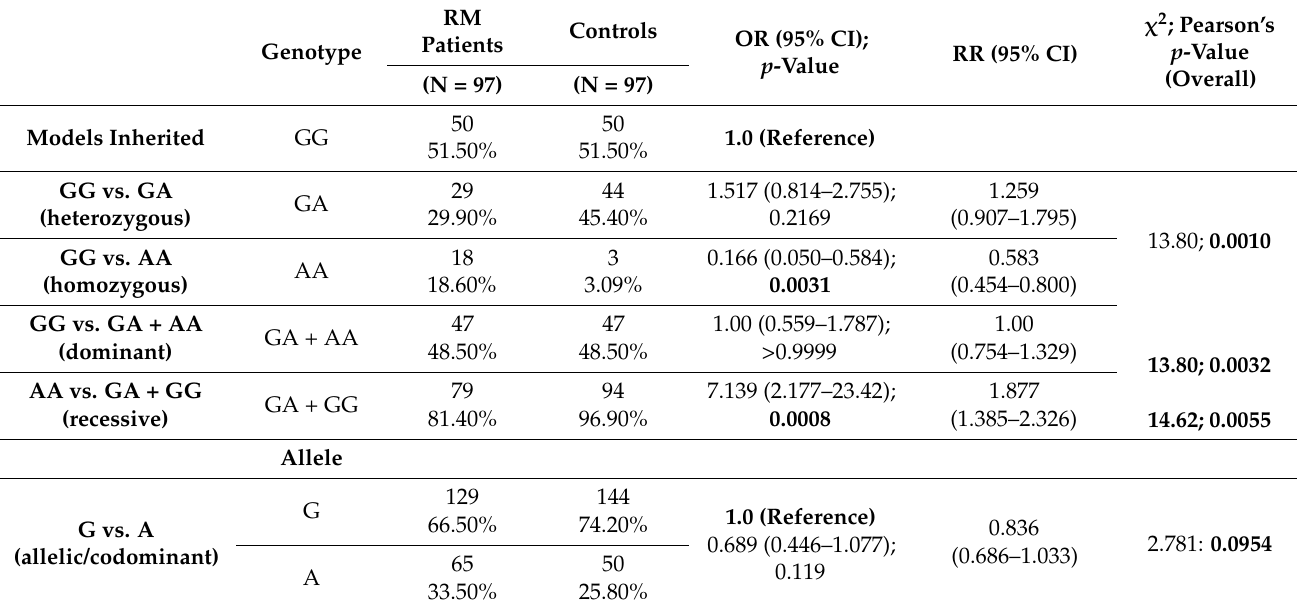
Table 3. Pattern of genotype and allele frequencies in IL17A (G/A) gene